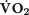
Dependence of total oxygen consumption (V˙O2), V˙O2 related to proton leak and V˙O2 related to ATP synthesis on ADP concentration.